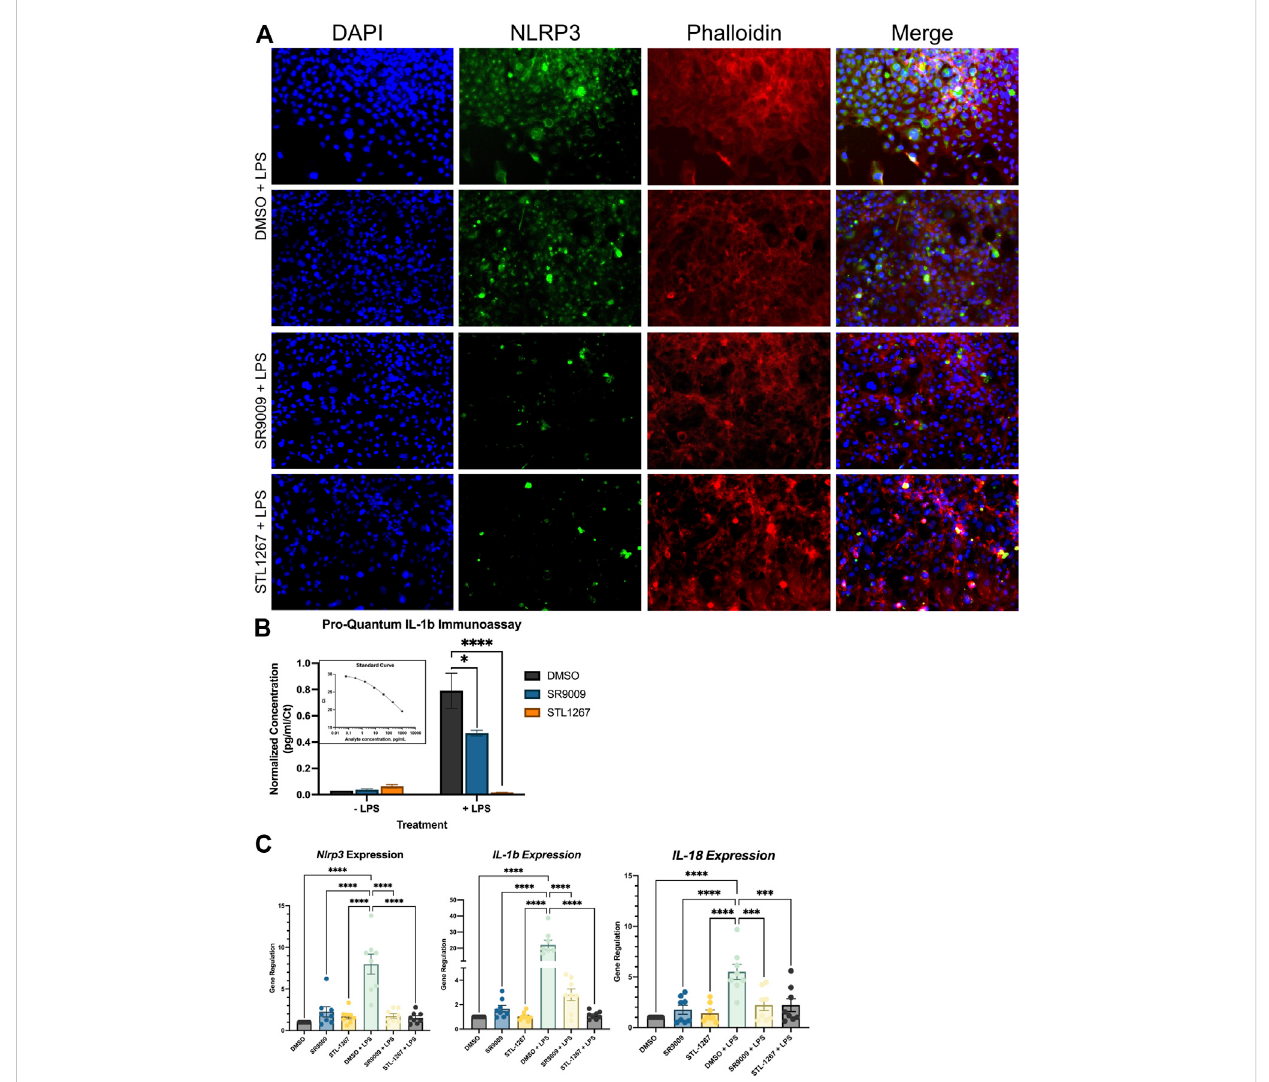
FIGURE 3 REV-ERB agonists have an anti-in fl ammatory effect on a human microglia cell line . (A) Immunostaining of LPS-stimulated HMC3 cells treated with either DMSO, SR9009, orSTL1267. Cells were immunostainedfor NLRP3 (green) and counterstained with DAPI(Blue) and Actin (Phalloidin; Red) to verify cellular occupancy of NLRP3. (B) ELISA assay evaluating the secretion of IL-1 β into the cell culture media. Results are shown as pg/mL normalized to C t value of IL-1 β per the ThermoFisher protocol using the Connect cloud software and graphed in Graphpad Prism. (C) Gene expression results for NLRP3, IL-1 β , and IL-18 . For all cell-based experiments, an n = 6 for each condition was used. Experiments were performed on three different occasions by different researchers, and the results were analyzed separately by ANOVA and represented by Mean ±